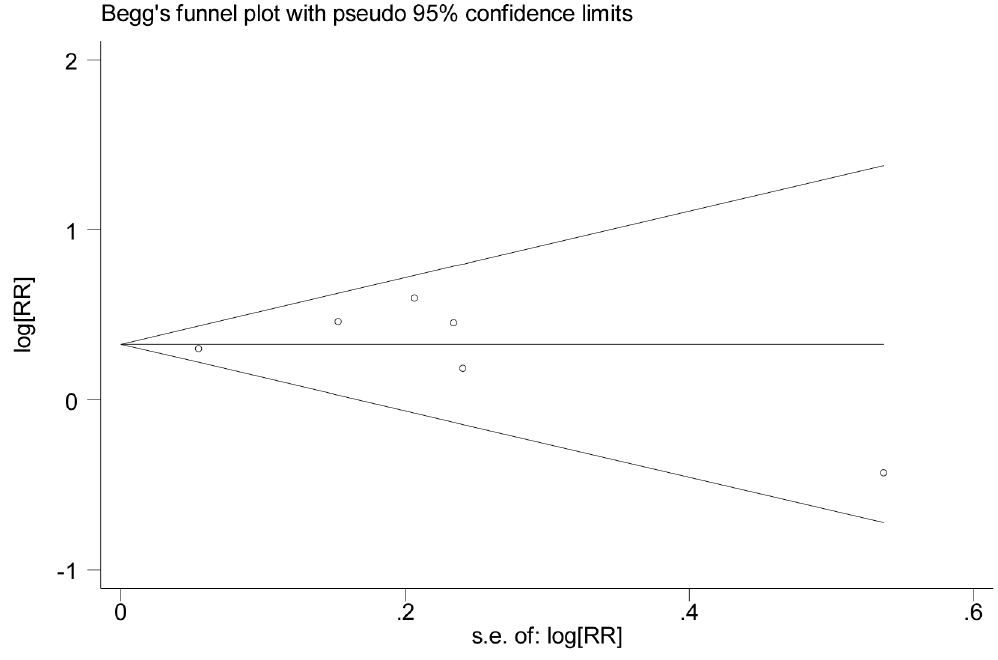
Figure 5. Funnel plot of the cohort studies evaluating the association between DM and POAG. Begg’s regression asymmetry test ( P =0.452). RR=risk ratio; DM=diabetes mellitus; POAG=primary open-angle glaucoma.